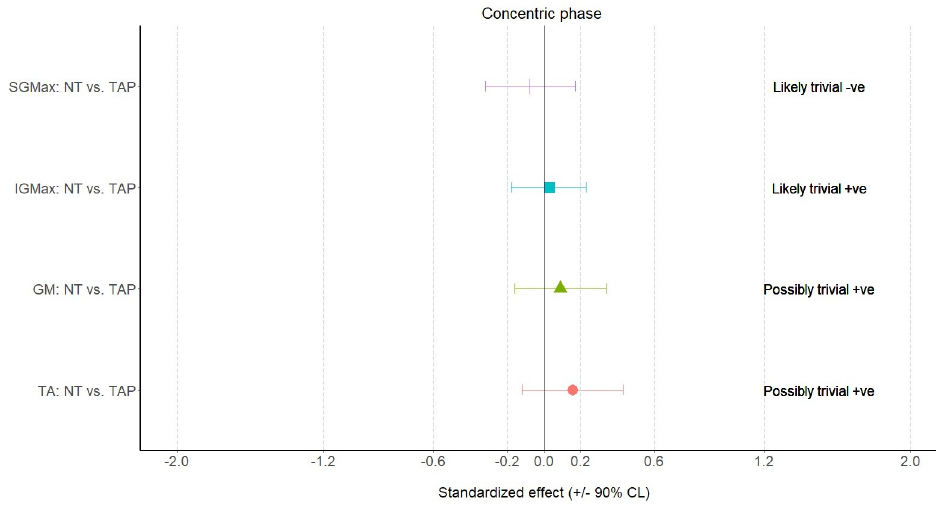
Fig 8. Results of surface electromyography during the concentric (up) phase of the bilateral squat. NT—non-taped condition; TAP—taped condition; SGMax—superior gluteus maximus; IGMax—inferior gluteus maximus; GM— gluteus medius; TA—tibialis